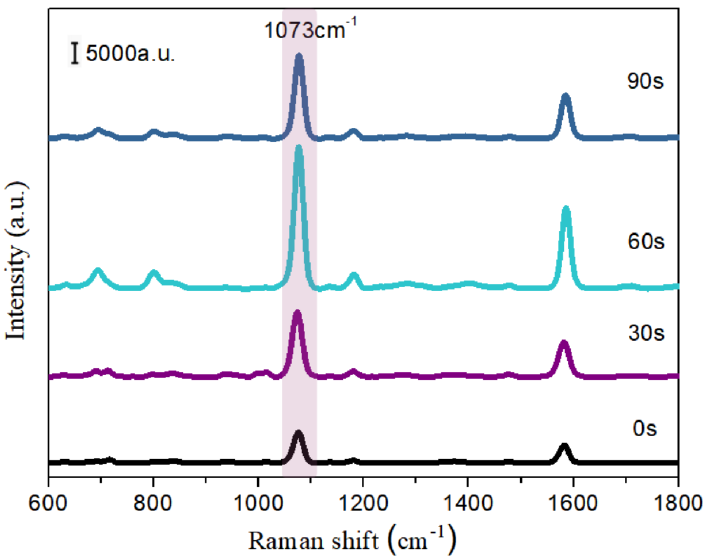
Figure 4. SERS spectra of 4-MBA molecules adsorbed on Ag-SiO 2 (10 nm) film after being etched for 0 s, 30 s, 60 s, and 90 s.